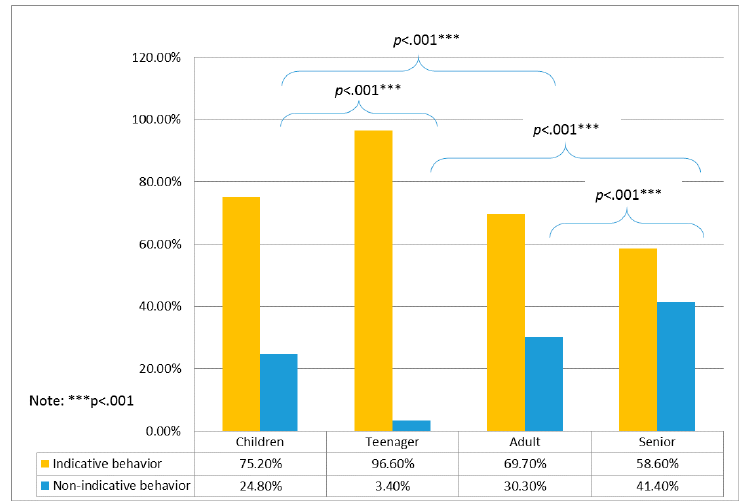
Figure 3. Post-hoc test results of user groups and indicative behaviors for the air walker.